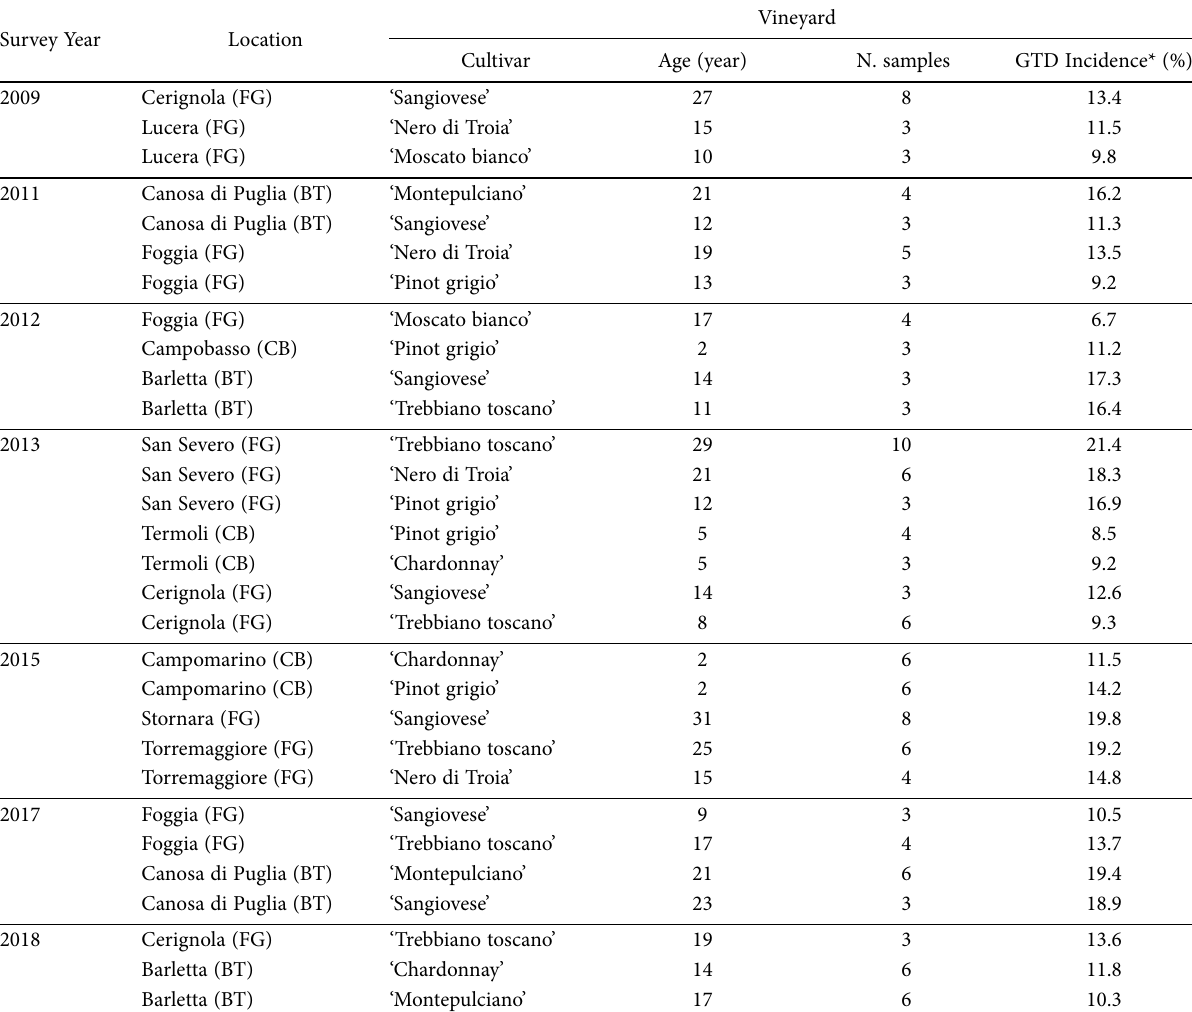
Table 1. Information on vineyards surveyed and sampled in the Apulia and Molise regions (southern Italy).